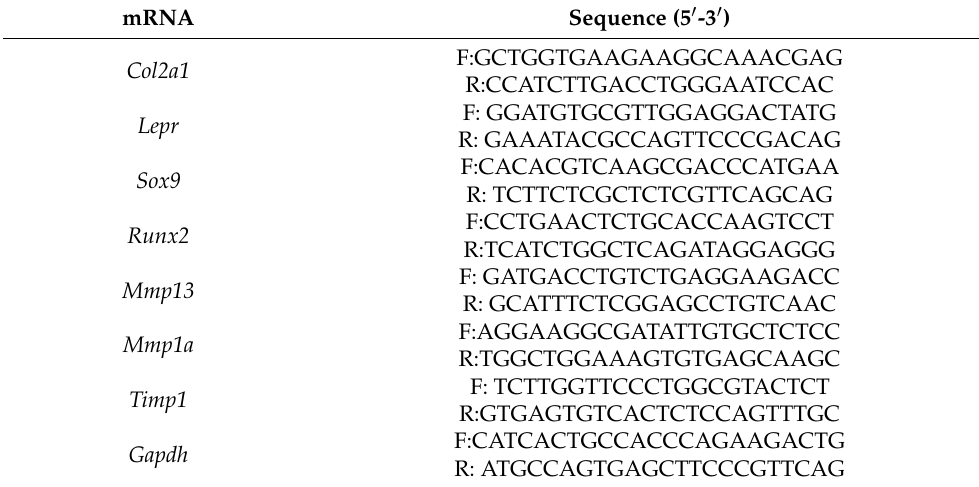
Table 1. Information of primers for real-time